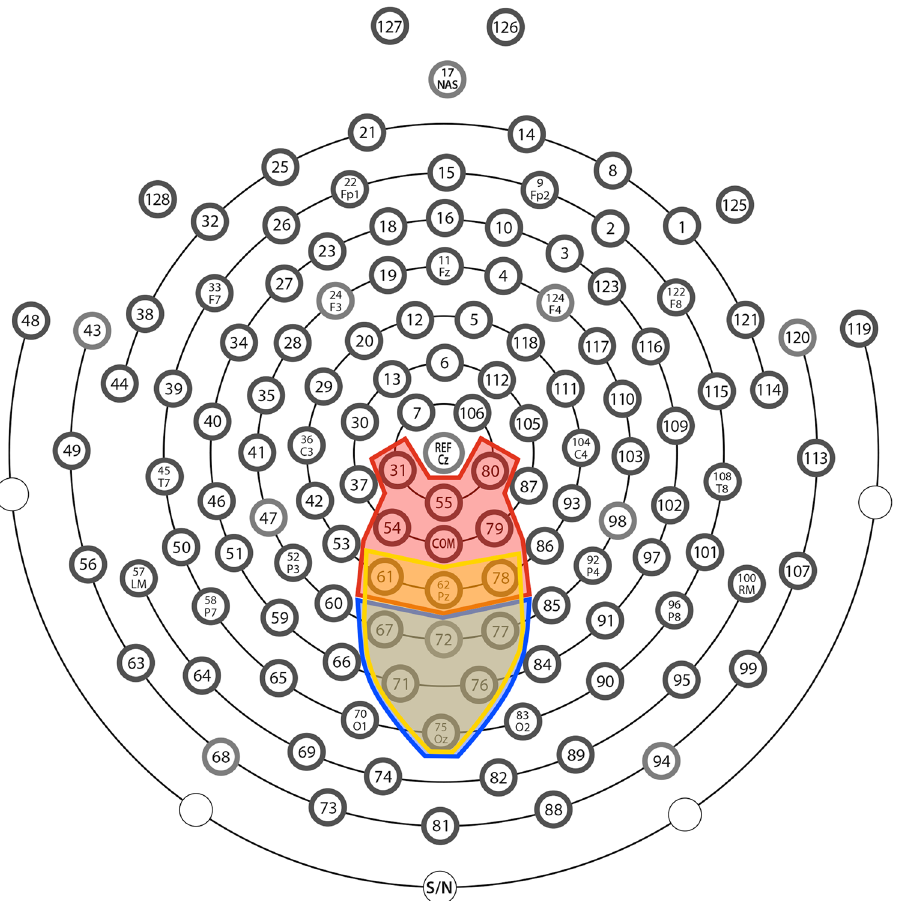
Figure 3. Figure depicting the top view of a 128-electrode Hydrocel geodesic cap (nose pointing up), indicating the selected cluster of electrodes to extract the P1, N1, and P3cue (in yellow); P3 parietal area (in red) and P3 occipital area (in